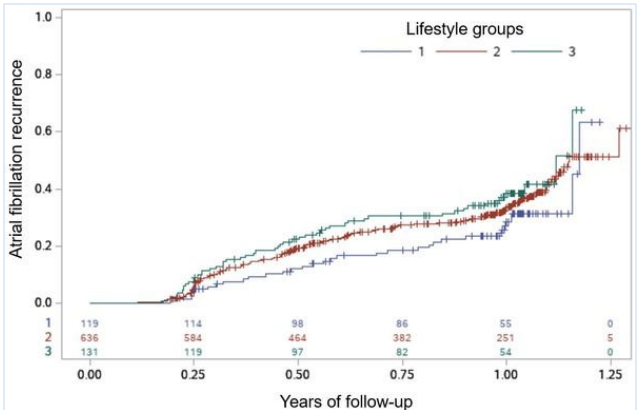
Figure 1 Survival curves for the three lifestyle